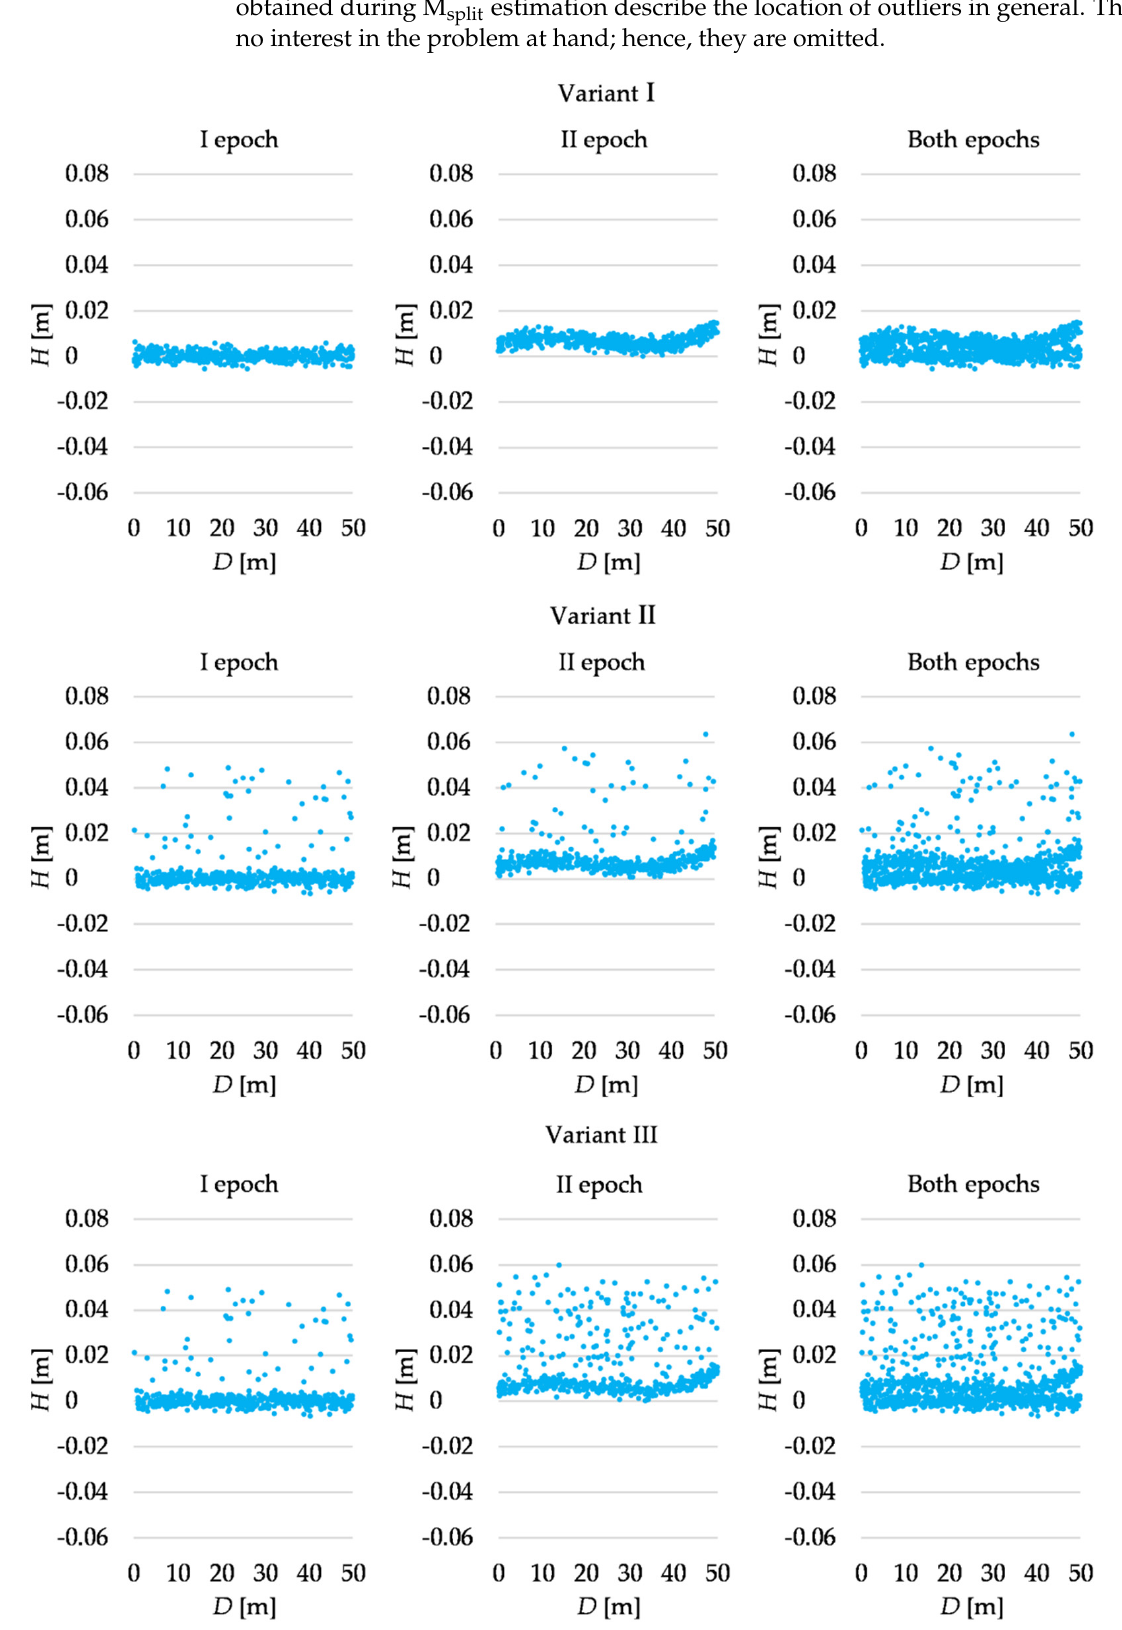
Figure 1. Observation sets for Variants I–III.